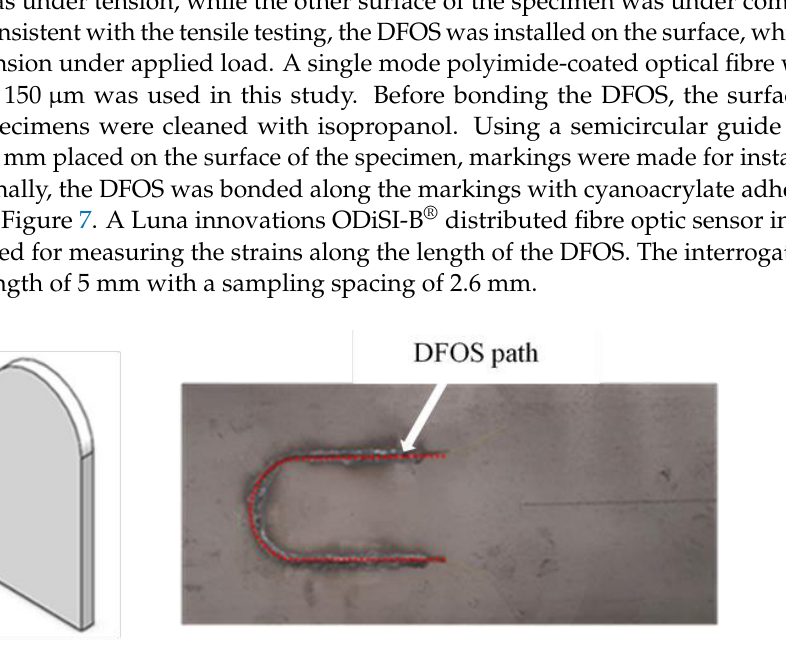
Figure 6. Details of strain rosettes: ( a ) triaxial strain rosette being placed; ( b ) strain rosettes installed on the semicircular path.